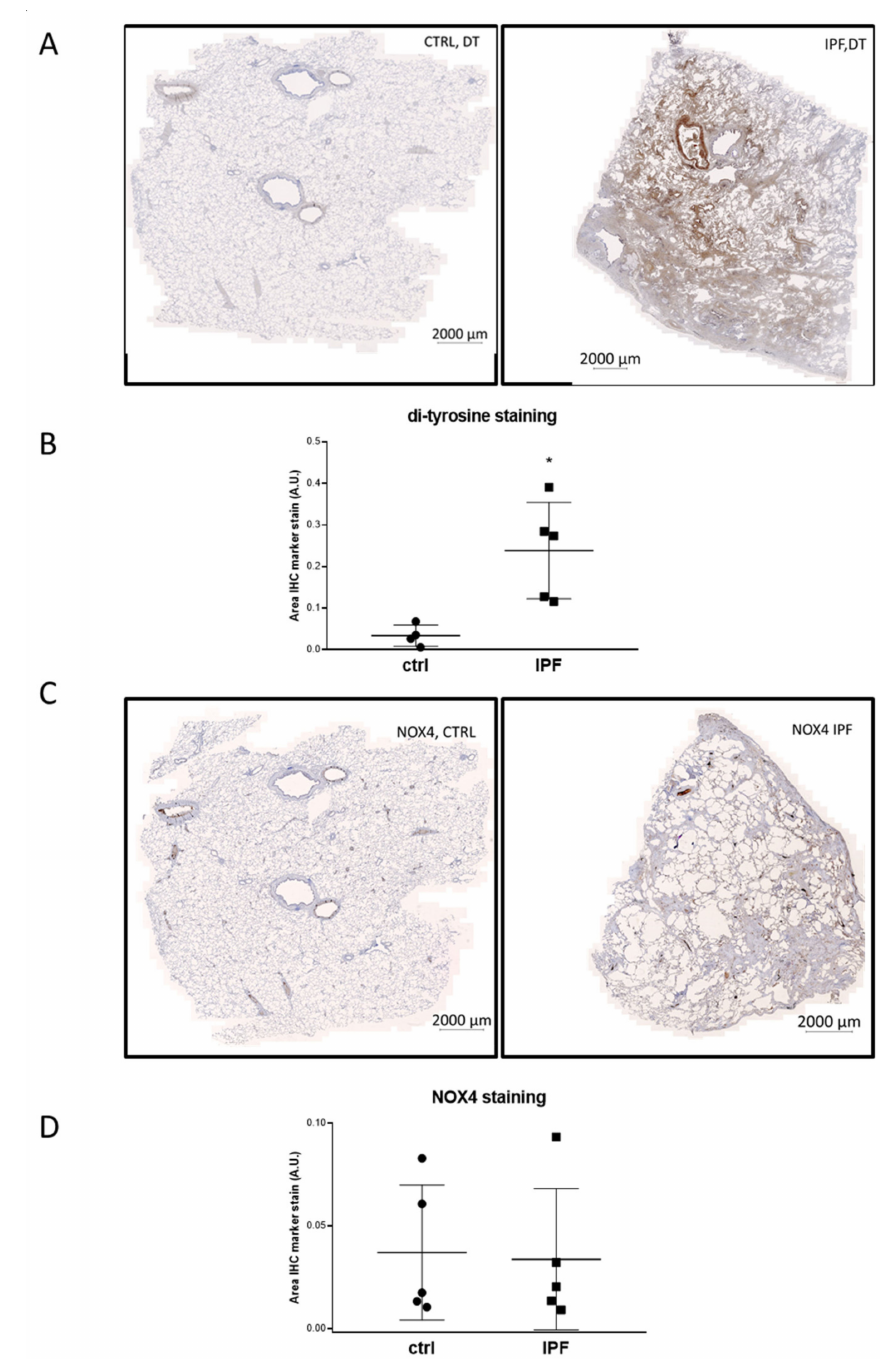
Figure 2. Representative images of DT ( A ) and NOX4 ( C ) staining in the indicated patients are shown for lungs. Quantification of staining for DT ( B ) and NOX4 ( D ). * p < 0.05 using Mann − Whitney nonparametric test. CTRL: control; IPF: idiopathic pulmonary